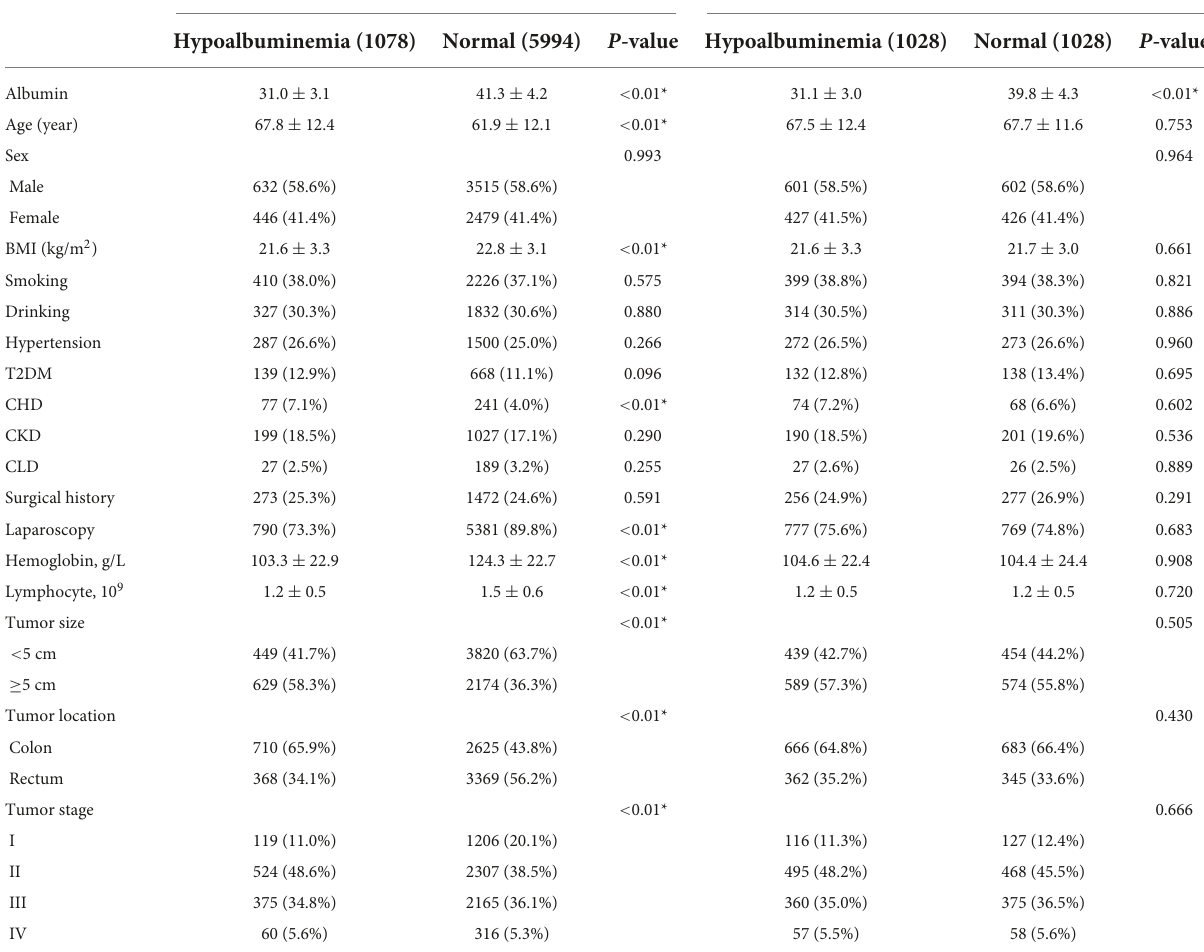
TABLE 1 Baseline characteristics before and after